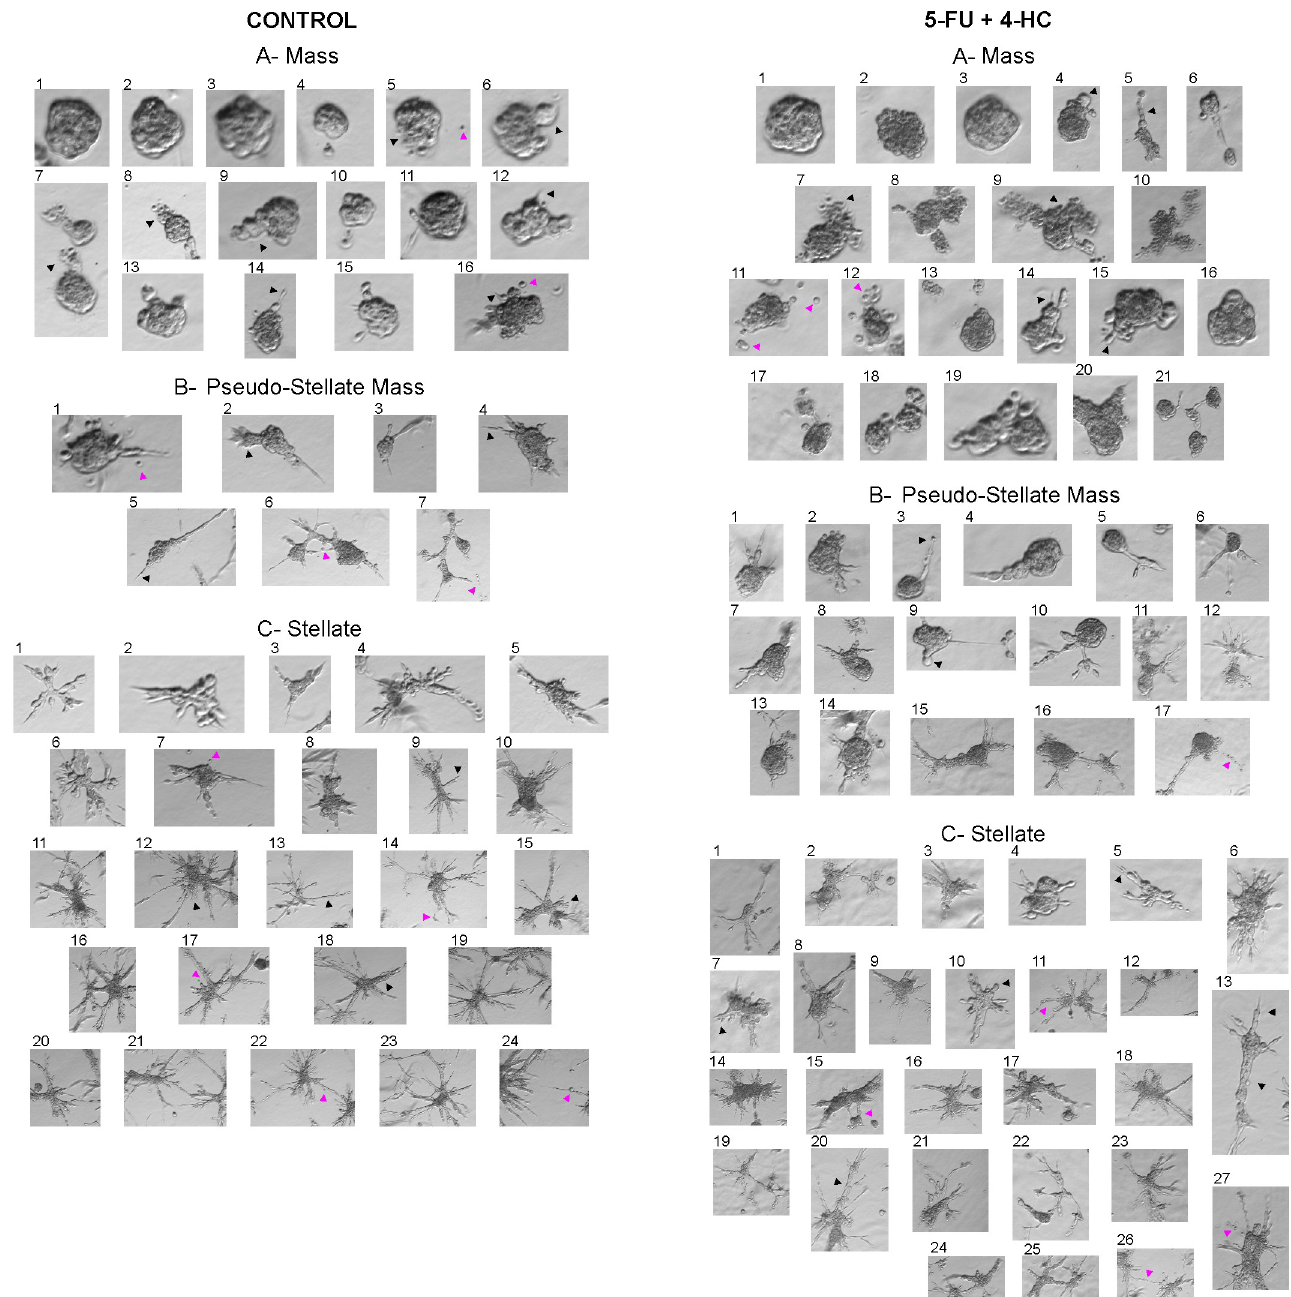
Fig 10. Invasive capacity of 231/LM2-4 cells under control and 5-FU+4-HC conditions using a 3D lrECM “on-top” assay. ( Control ): Mass structures (A): round morphology (1–3), irregular morphology showing collective cell migration as chains of few cells with smooth borders ( Δ 9), buds ( Δ 6) or as disorganized masses ( Δ 5). Single cell protrusions ( Δ 12,14,16). Multicellular streaming with no apparent junction contacts ( Δ 7,8). Dissemination of single tumor cells (pink Δ 5,16). Pseudo-Stellate Mass structures (B): multicellular collective protrusive migration with leading cells with invadopodia ( Δ 2,4,5). Dissemination of single tumor cells (pink Δ 1) and collective dissemination (pink Δ 7). Contacts between several structures (pink Δ 6). Stellate structures (C): several multicellular chains with a collective cell migration pattern of invasion and protrusive leading front with one ( Δ 9) or multiple leading cells ( Δ 15) with invadopodia. Multicellular invasive chains with 1–2 cells in diameter ( Δ 13) or broad masses of cells ( Δ 18). Secondary branches at the lateral margin of the invasive chains ( Δ 12). Cell dissemination (pink Δ 7,14,17). Contacts between several structures (pink Δ 22,24). (1 μ M 5-FU + 0.01 μ M 4-HC ): Mass structures (A): round morphology (1–3), irregular morphology exhibiting collective cell migration as chains of few cells with smooth borders ( Δ 5), buds ( Δ 4), and structures with single-cell protrusions ( Δ 14,15). Multicellular streaming ( Δ 7,9). Dissemination of single tumor cells (pink Δ 11) and group of cells (pink Δ 12). Pseudo-Stellate Mass structures (B): multicellular collective protrusive migration with leading cells with invadopodia ( Δ 3) or leading buds ( Δ 9). Dissemination of group of cells (pink Δ 17). Stellate